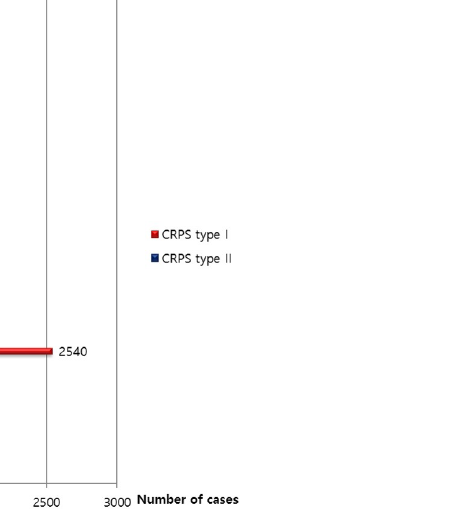
Fig 6. Regional (Provincial) distribution of CRPS types I and II in